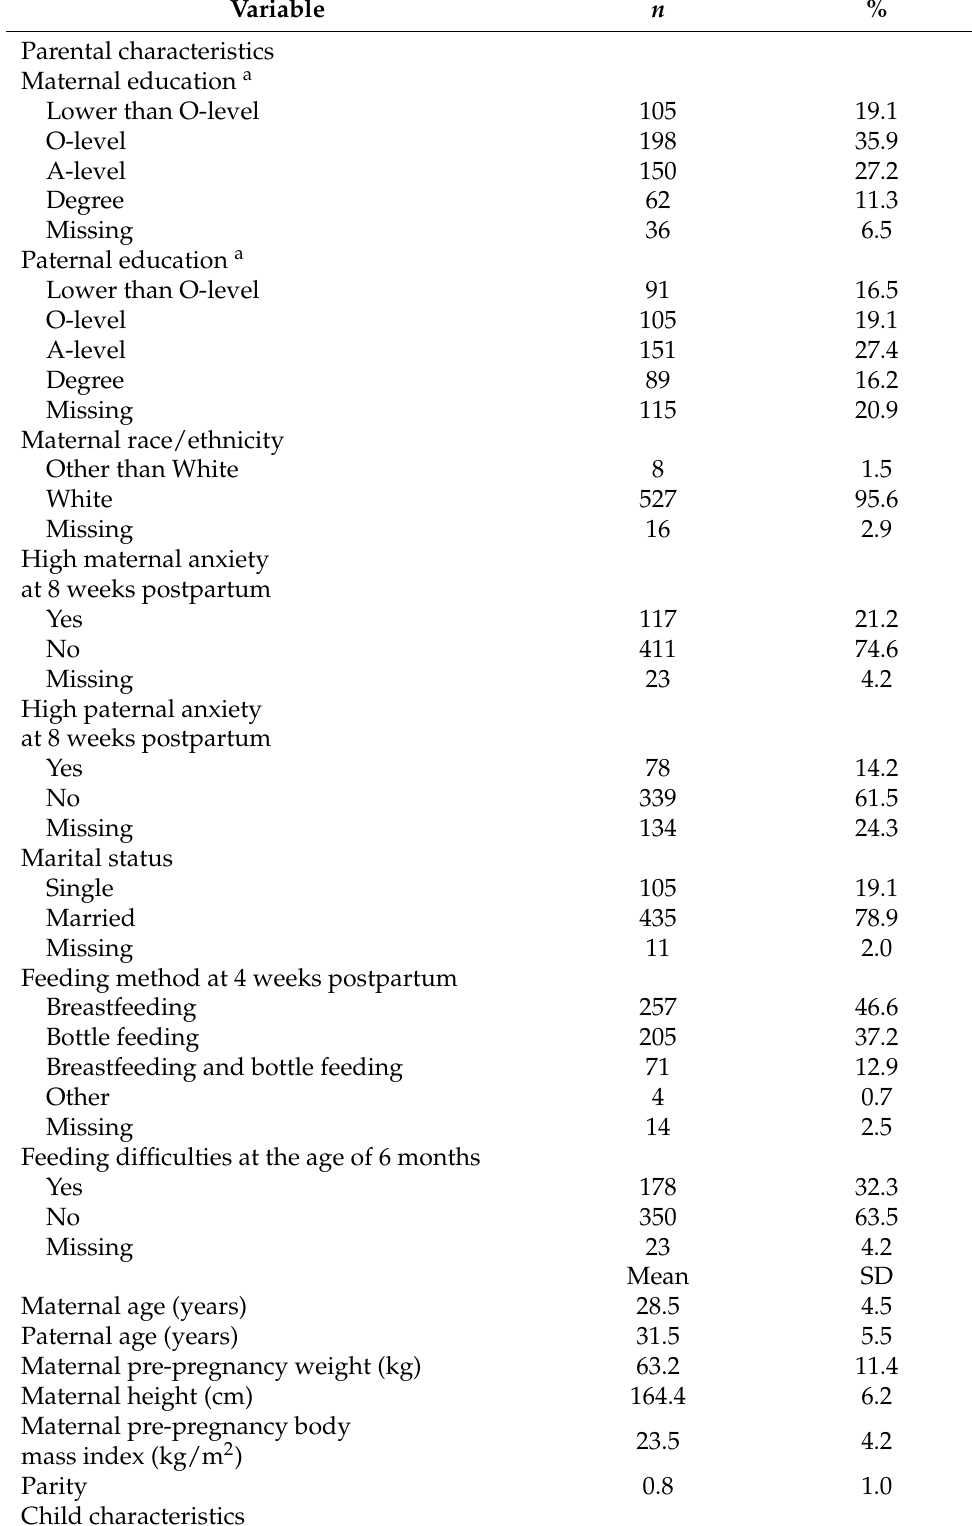
Table 1. Characteristics of study participants (total n =